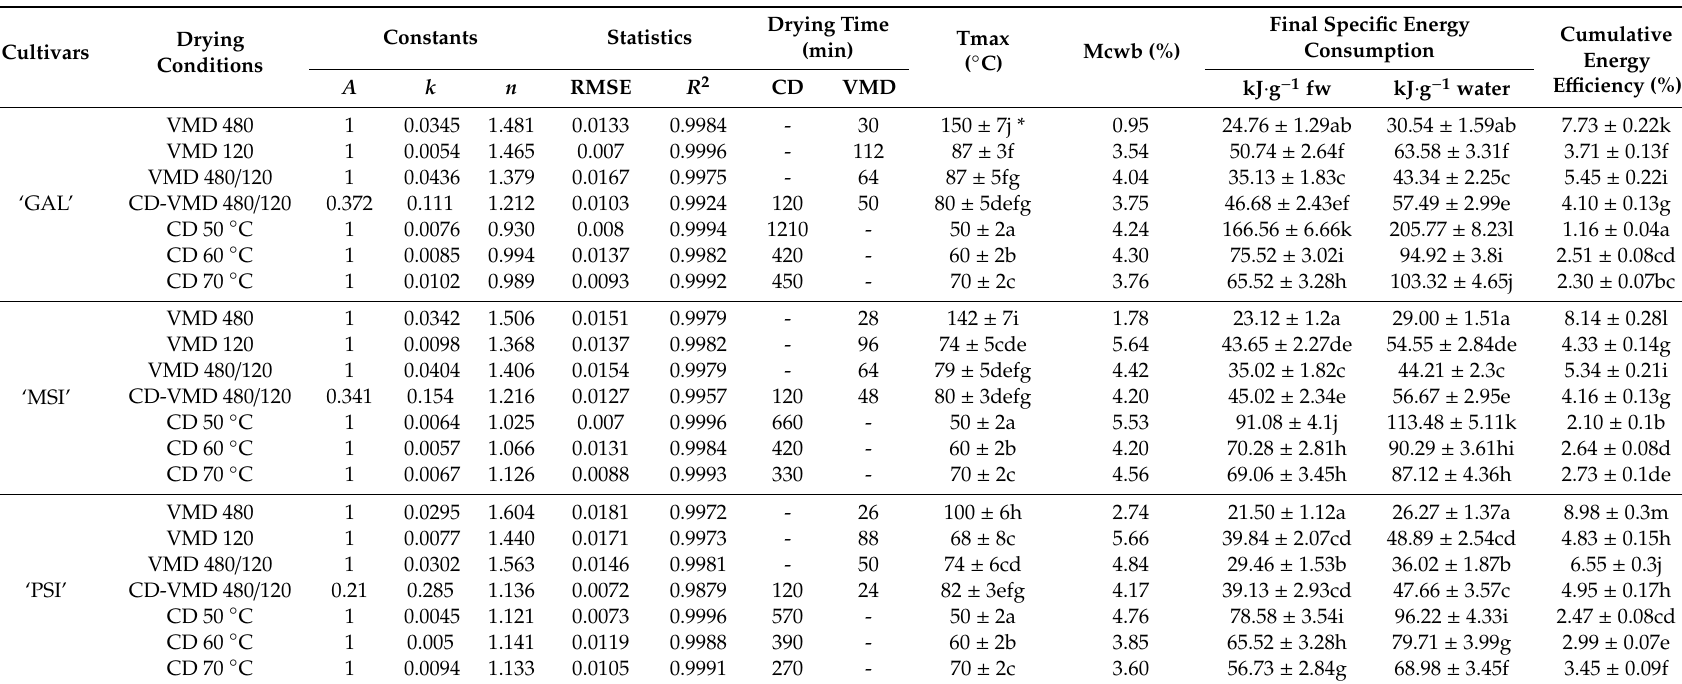
Table 1. Drying time, maximum temperature of the samples, final moisture content, final specific energy consumption, cumulative energy e ffi ciency and constants of the models describing the drying kinetics of jujube